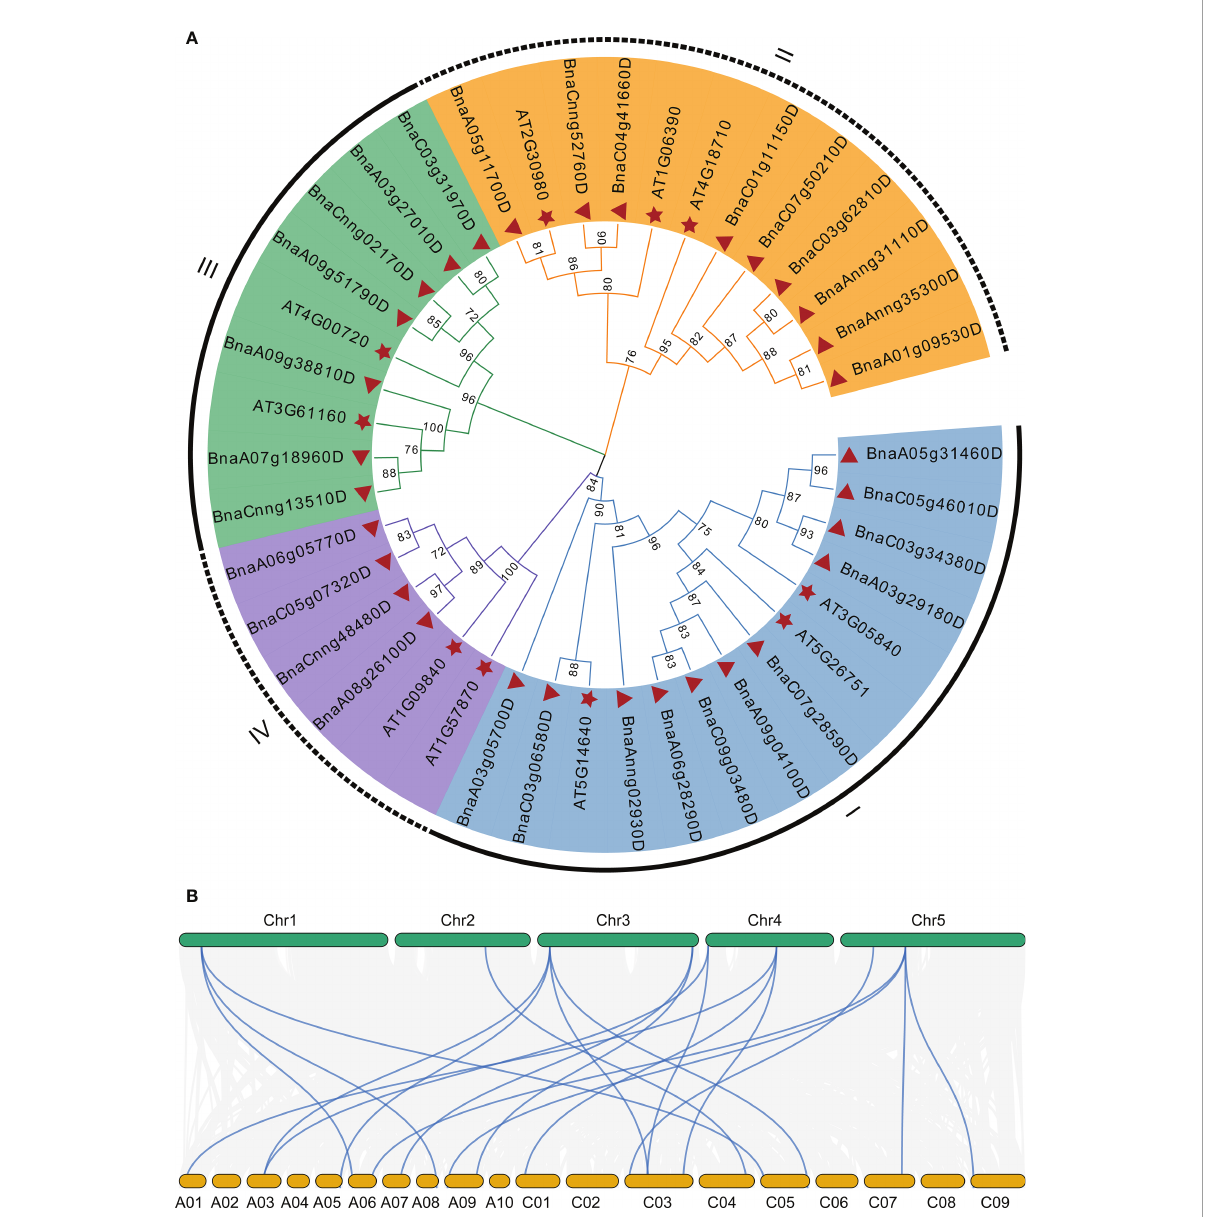
FIGURE 4 Phylogenetic and syntenic analysis of AtGSK3s and BnGSK3s . (A) Phylogenetic analysis. (B) syntenic analysis. The green and yellow blocks represent Arabidopsis and B . napus chromosome,